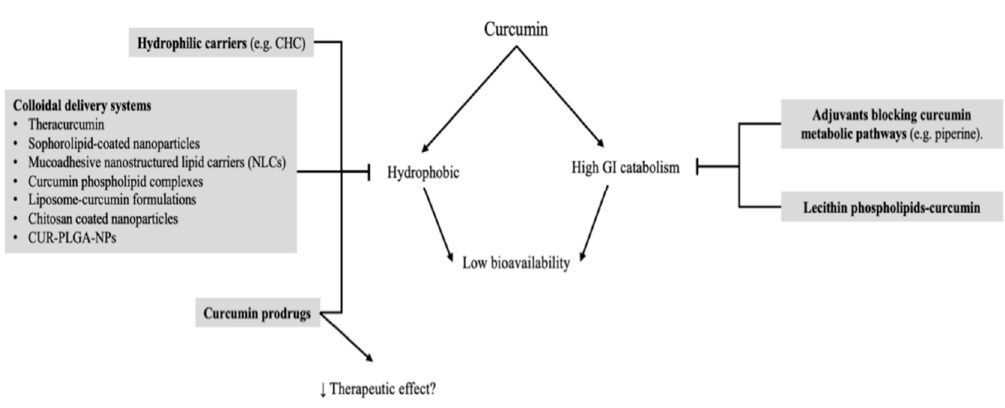
Figure 1. Schematic representation of molecular mechanisms involved retinal ganglion cell transcription and vascular endothelial growth factor levels. Down arrow stands for reduction.